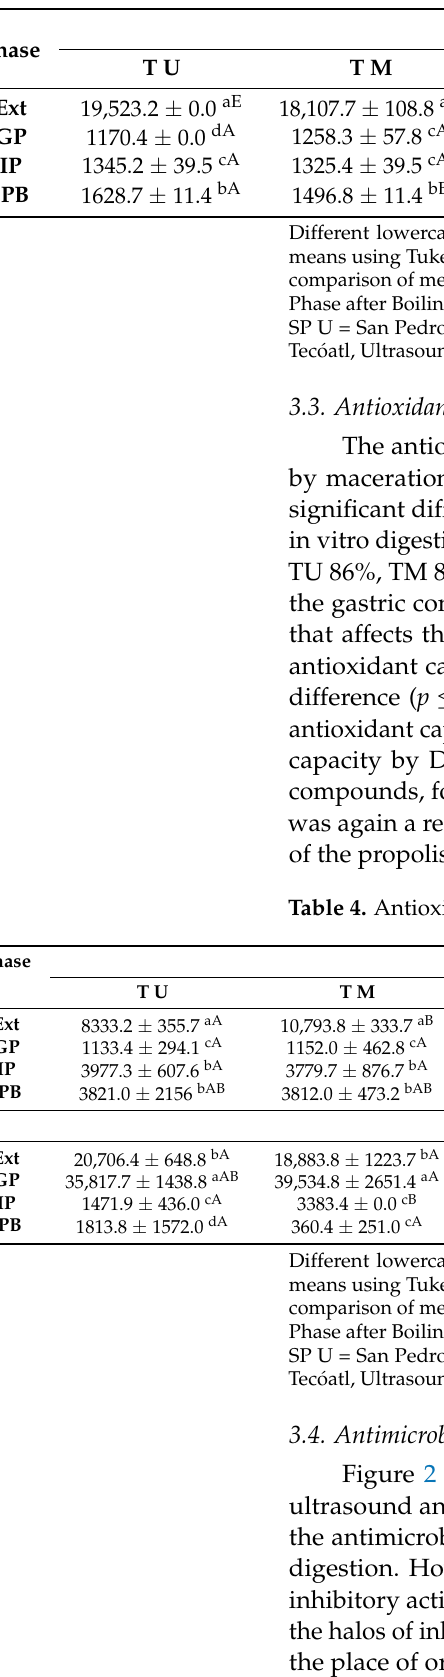
Table 3. Behavior of total flavonoids during the in vitro digestion of different propolis extracts.